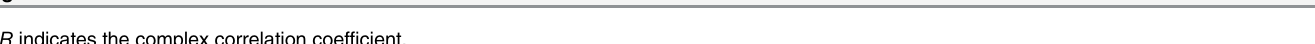
Table 5. Significance test and summary table of the multivariate stepwise regression model of soil erosion driving factors in the ecological resto- ration area. Model